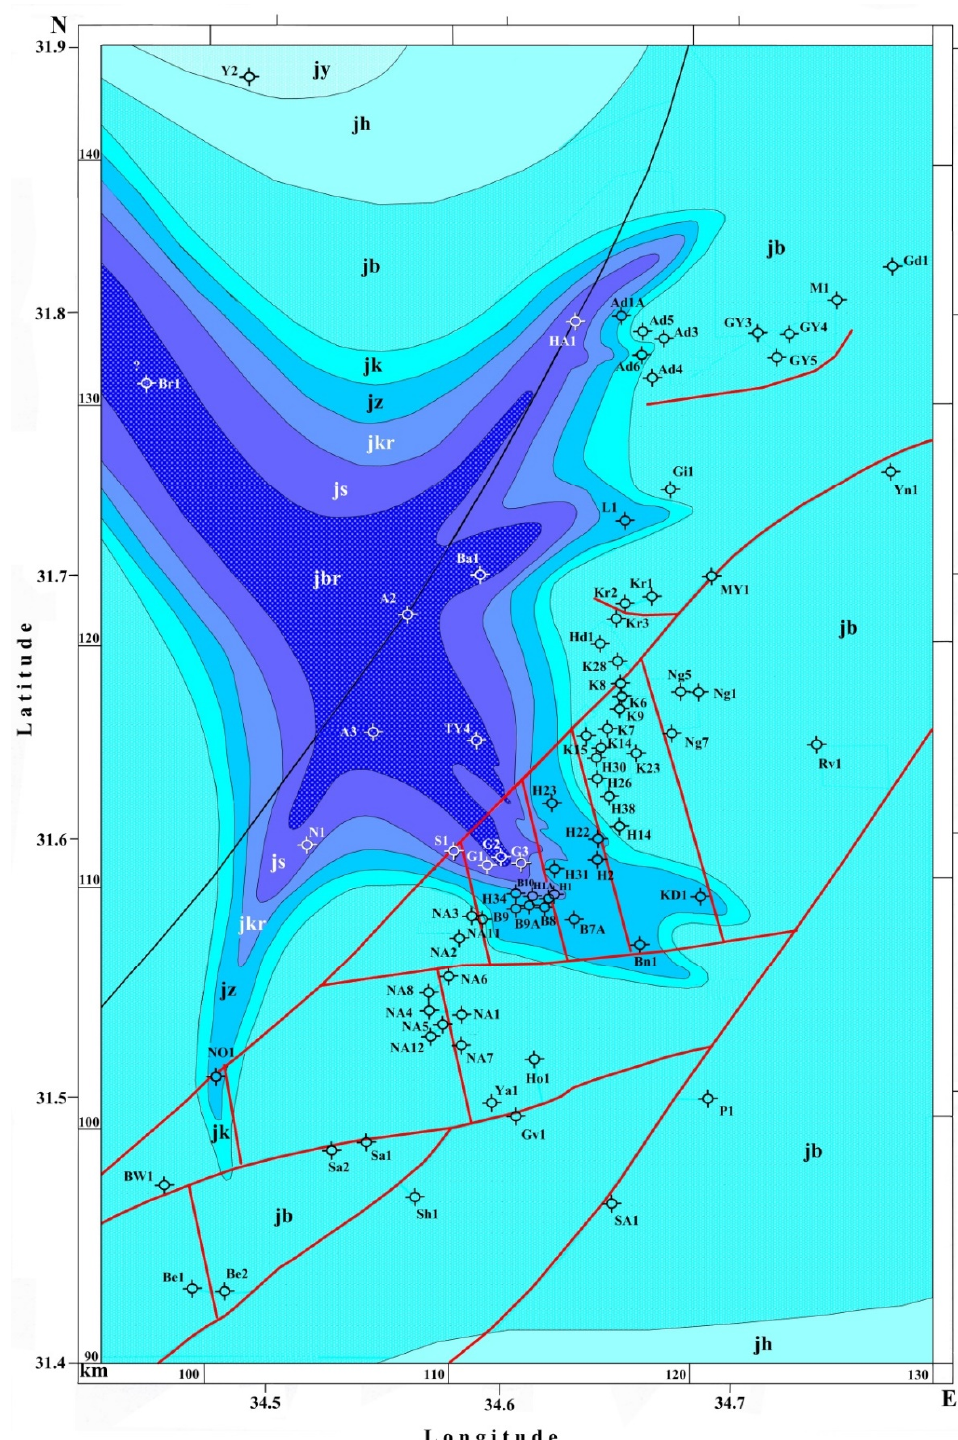
Figure 8. Palaeogeological map for the top Jurassic of the Heletz–Ashdod oil field and adjacent